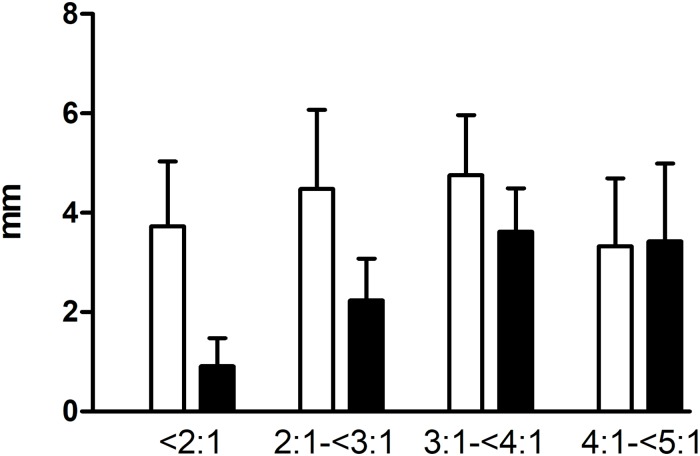
75 abdominal midline closure measurements in cats categorized by SL:WL ratios <2:1, 2:1-<3:1, 3:1-<4:1, and 4:1-<5:1 analyzed for the mean SI ± SD and mean TB ± SD.